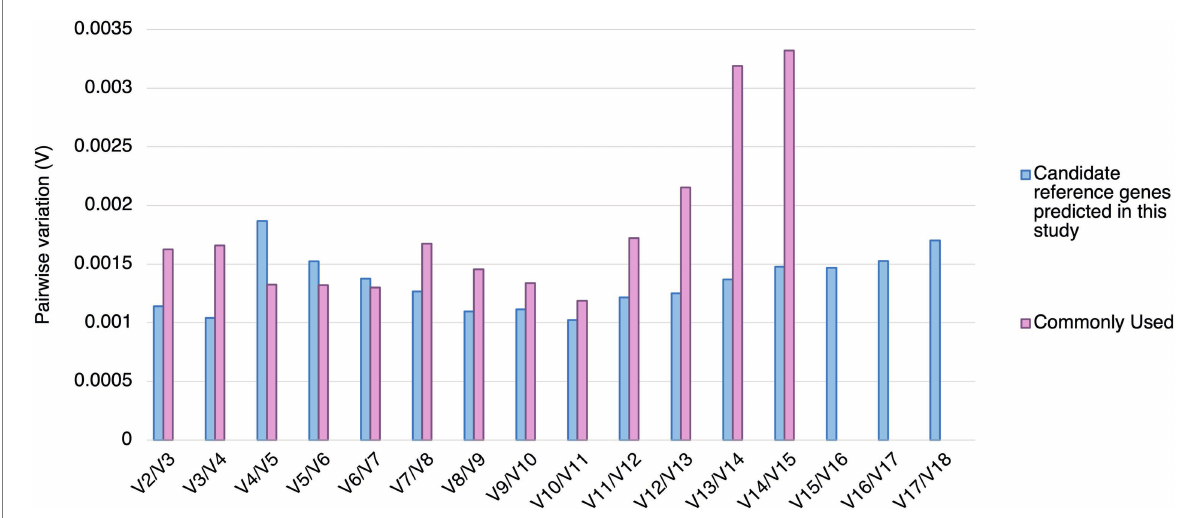
FIGURE 4 Pairwise variation (V) of the candidate reference genes predicted in this study and reference genes commonly used in previous studies calculated by geNorm. The pairwise variation representing (V n /V n + 1 ). The threshold value of V for accessing the optimal number of the reference genes for RT-qPCR normalization is 0.15. n represents the number of reference gene required for expression normalization in RT-qPCR.